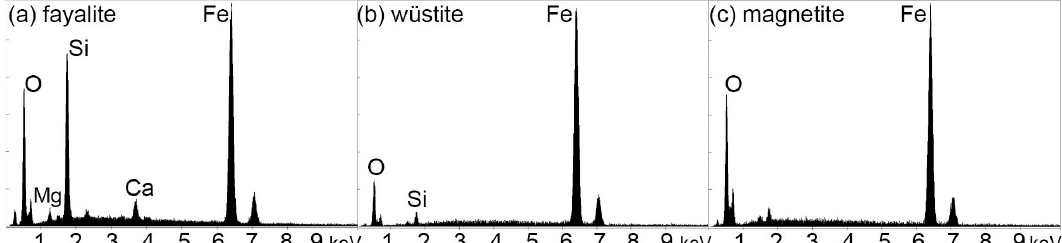
Figure 13. Selected SEM-EDS spectra from Figure 12d illustrating composition of magnetic Casaccia slag. ( a ) fayalite, ( b ) wüstite (high Fe/O ratio); ( c ) magnetite (lower Fe/O ratio). Only K α and L α peaks are labeled; vertical axis is count intensity.